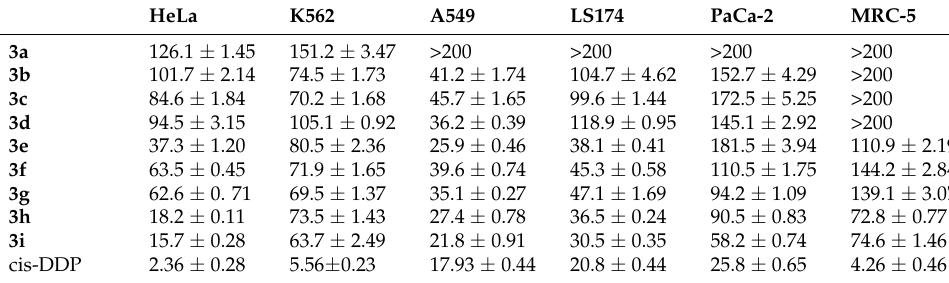
Table 2. Cytotoxicity of 3a–i (MTT in µ M). Table 1. Antimicrobial activity of 3a–i . MIC values are presented in μ M.